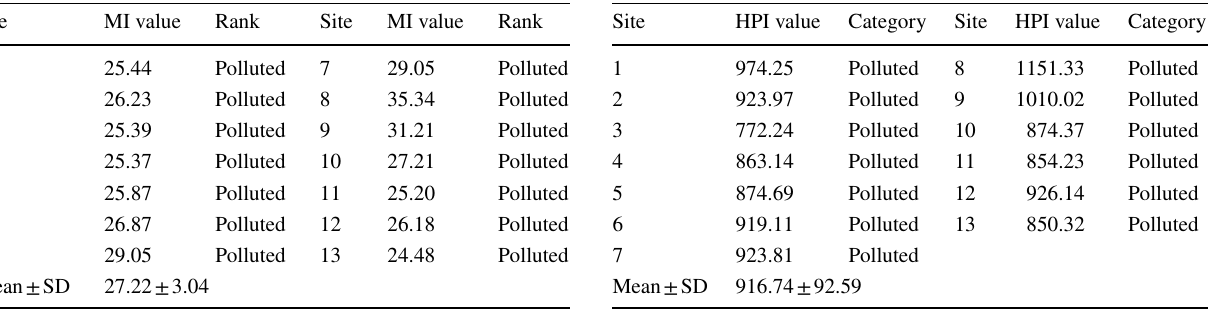
Table 6 Metal index (MI) of the measured heavy metals in Mariout Lake water according to the guideline levels for aquatic life